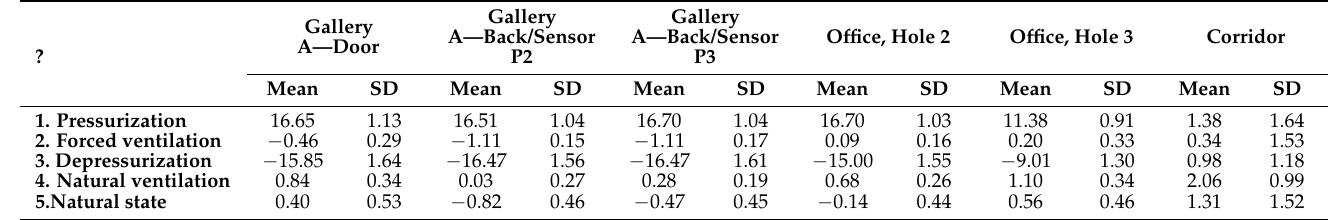
Table 4. Summary of pressure differences (Pa) achieved at mitigation tests. Reference level on the office floor.